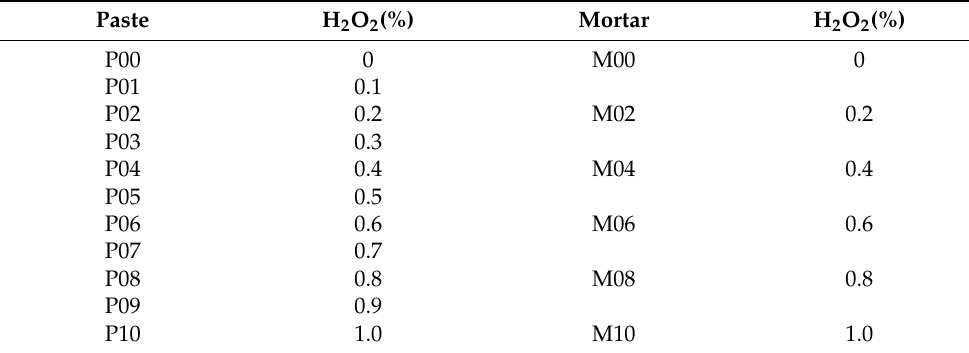
Table 1. Concentration of hydrogen peroxide